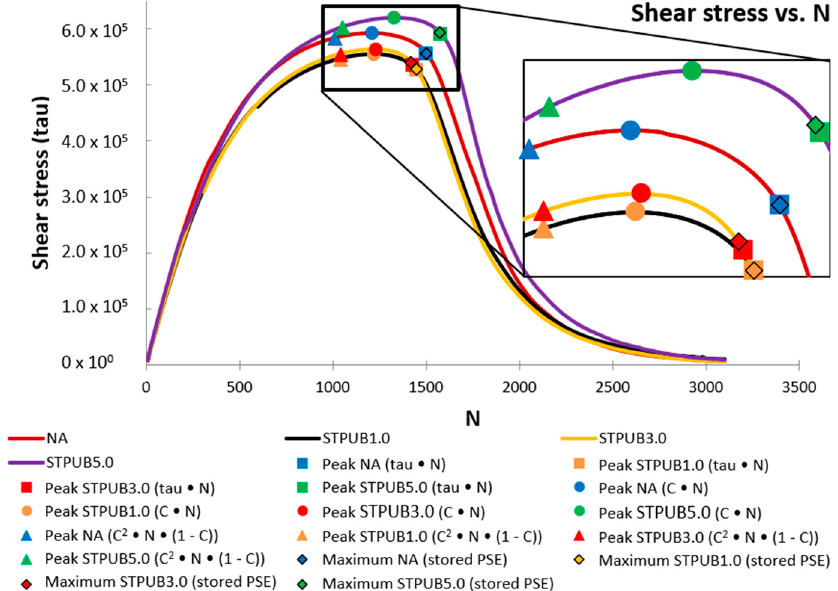
Figure 8. Failure de fi nition points de fi ned on the stress amplitude curve.